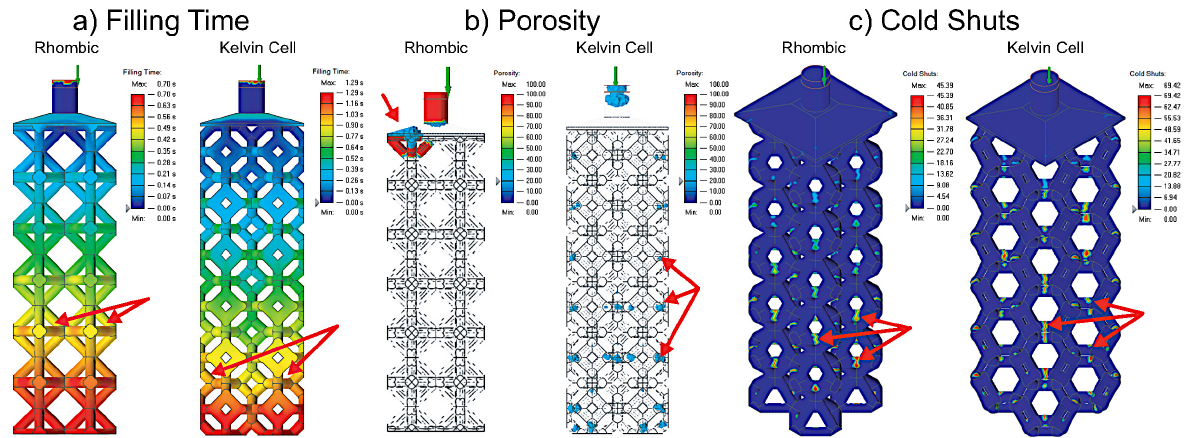
Figure 6. Flow simulation results for rhombic and kelvin